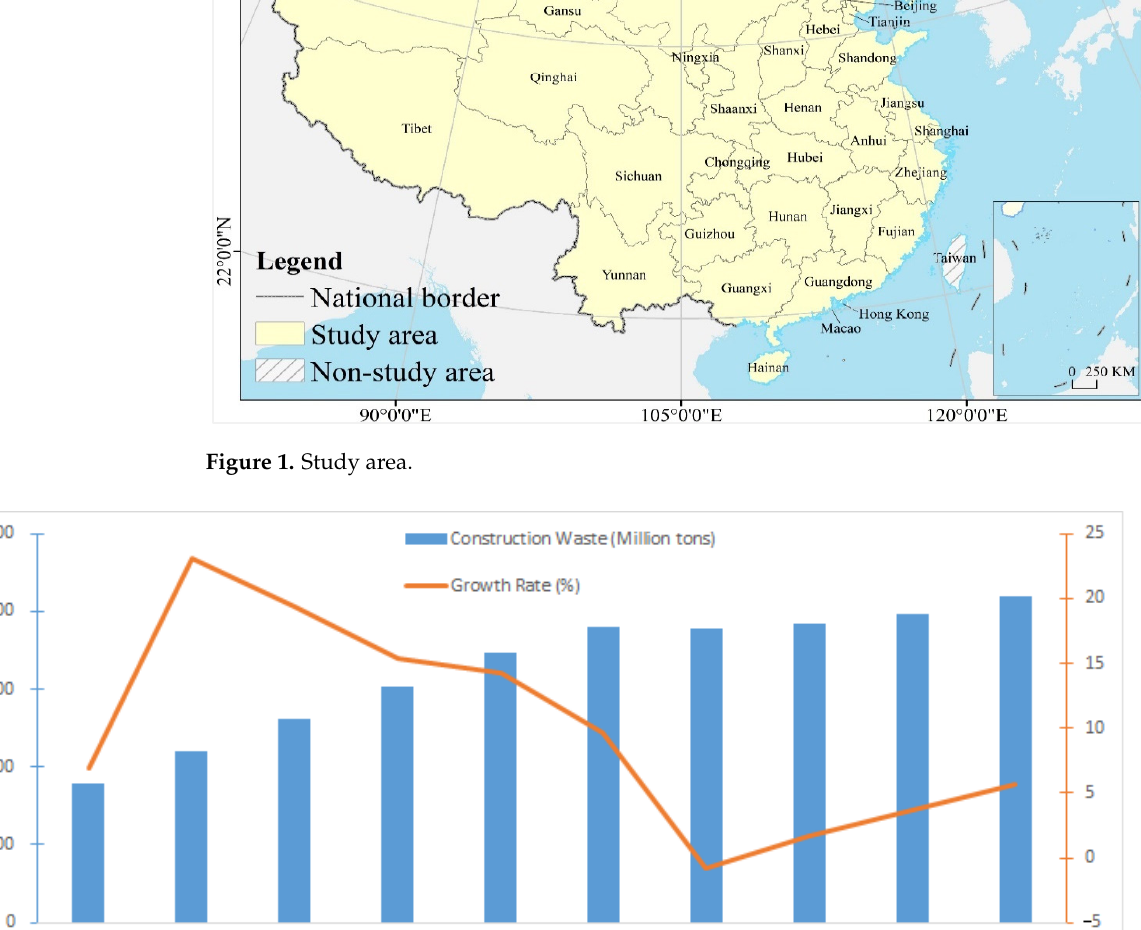
Figure 2. Analysis on the change of construction waste in the study area.